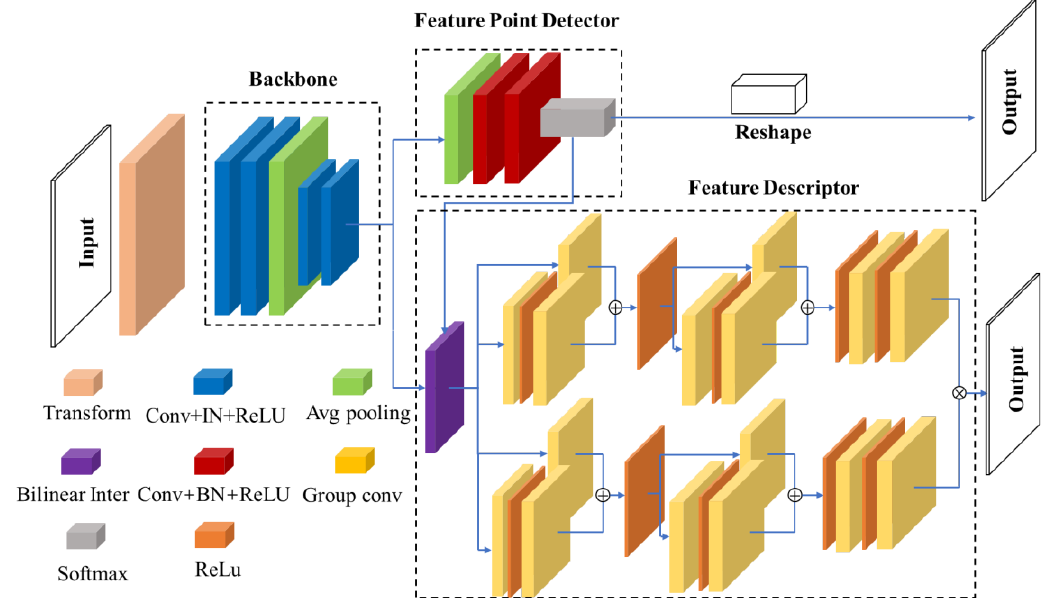
Figure 3. Proposed pseudoinverse Siamese network structure overview for transformation invariance feature detection and description.